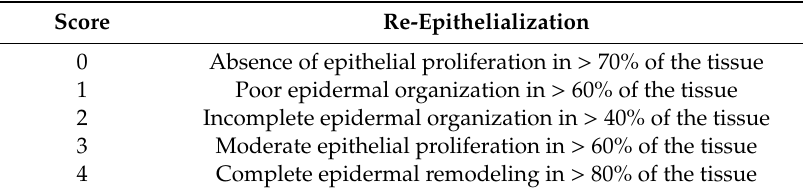
Table 1. Scoring of histological changes in wound